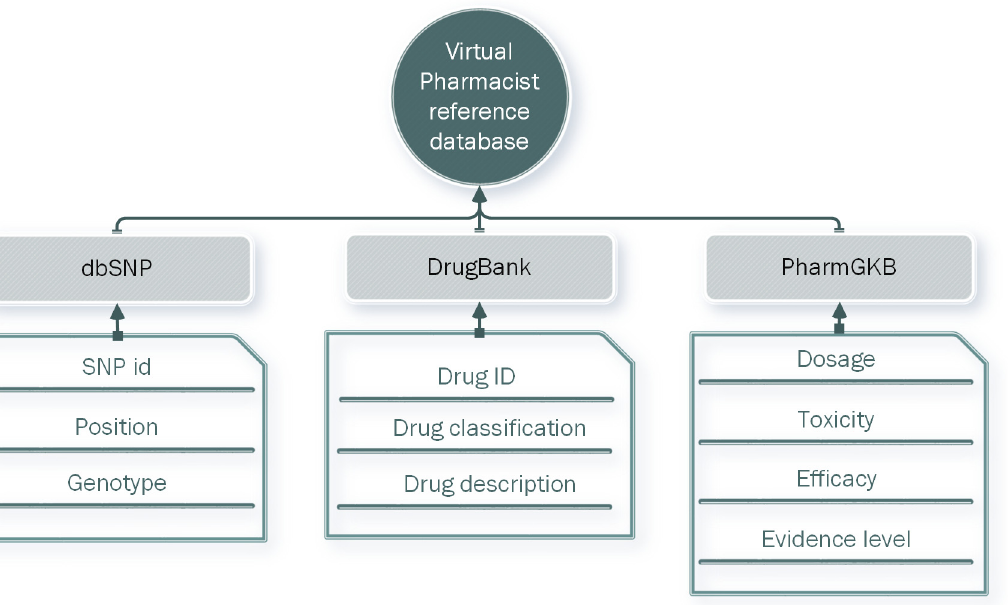
Fig 3. Structure of the reference database of Virtual Pharmacist (VP). Different data sources were integrated to construct the gene-drug interaction reference database.